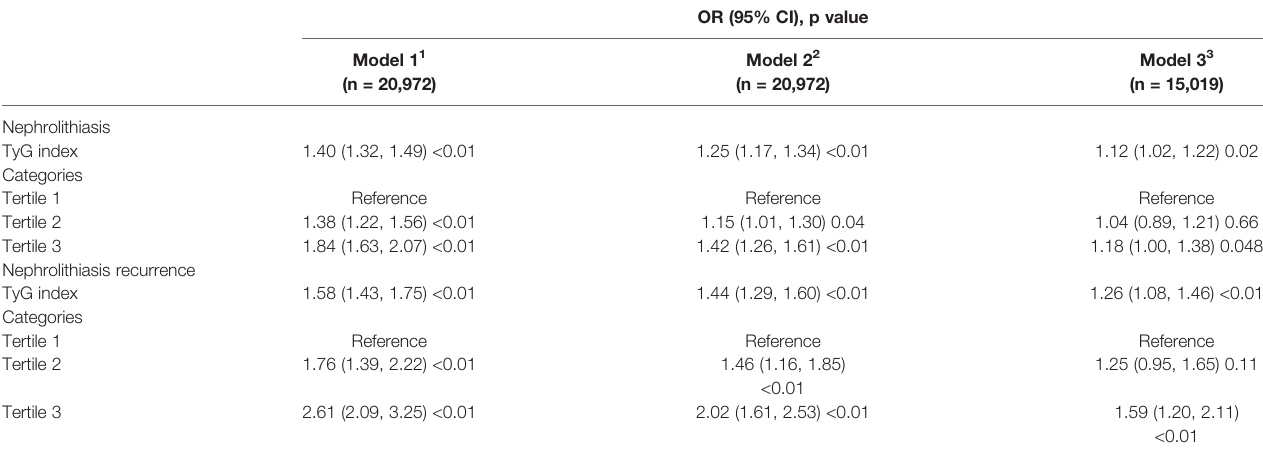
TABLE 2 | Association of TyG with kidney stone and a recurrence of passing kidney stones.